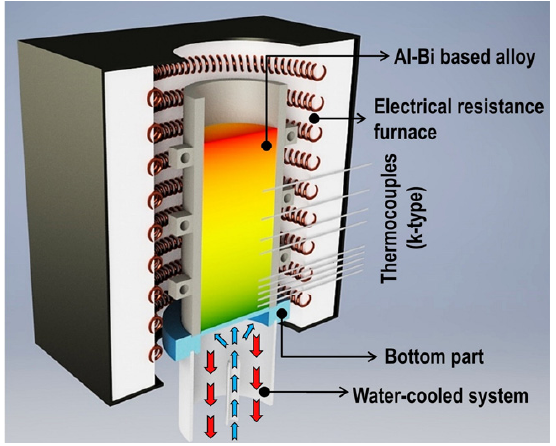
Figure 1. Solidification furnace used for producing directionally solidified (DS) castings.